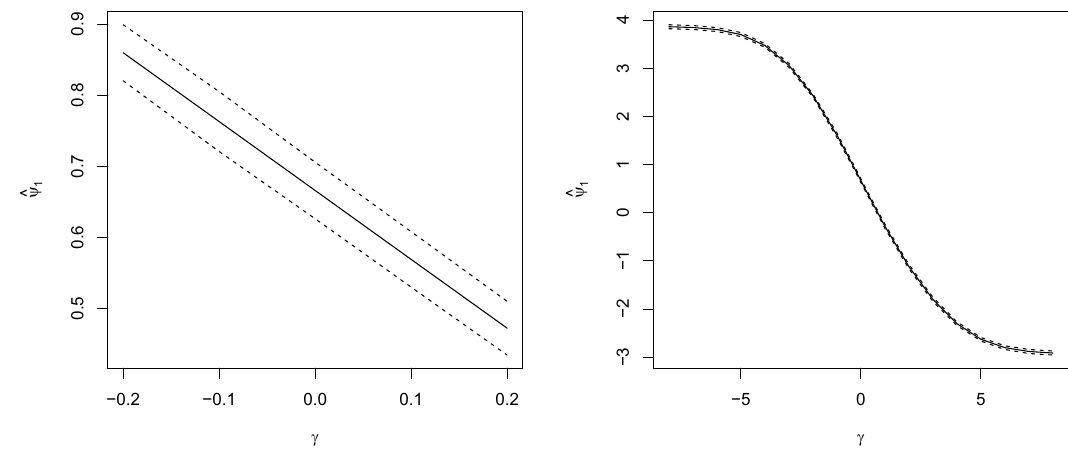
Figure A1: The estimated marginal causal log odds ratio ( solid lines ) for behavior pattern and CHD together with pointwise 95% con fi dence limits ( dashed lines ) for the marginal causal log odds ratio, as functions of the negative of the sensitivity para - meter γ